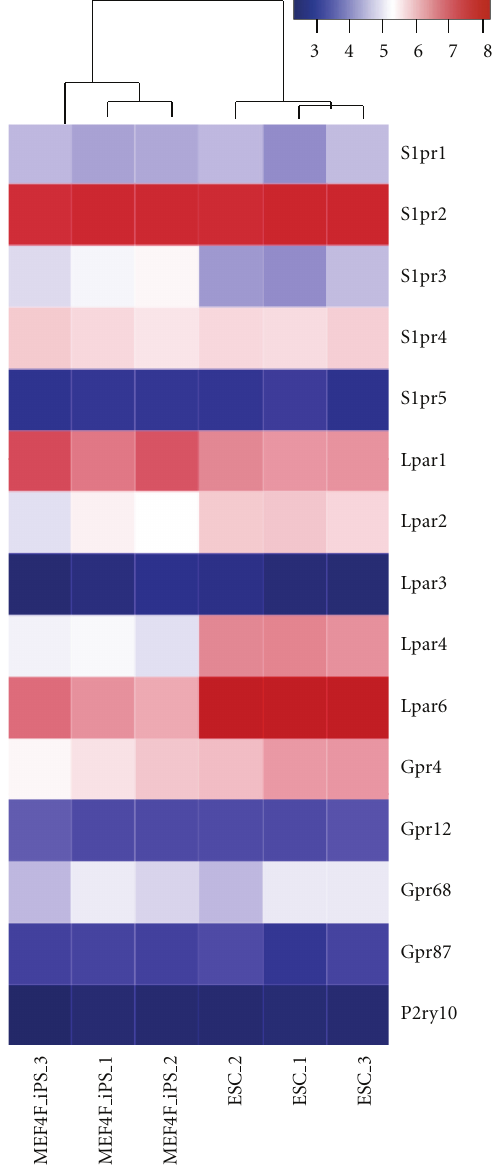
Figure 1: Lysophospholipid receptor expression in murine pluripo- tent stem cells . Heatmap of microarray gene expression of a list of mouse bioactive lipid receptors. Gene expression color key is shown in log2 scale. Microarray data were downloaded from the GEO database; accession numbers GSE10806.